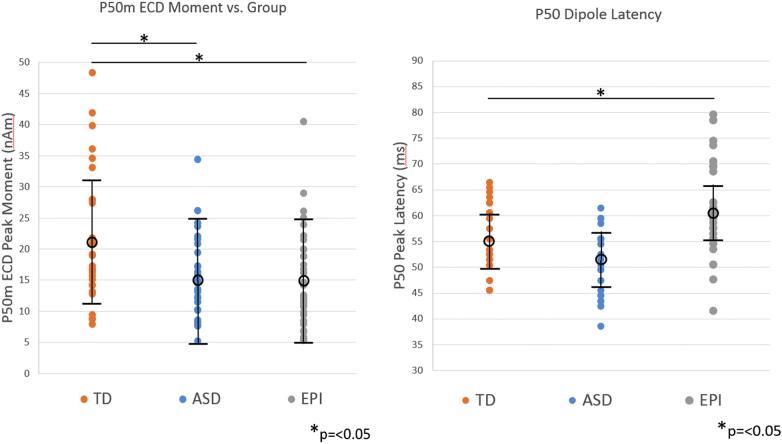
Left panel: Group mean and standard deviations for dipole moment reveal a significant overall effect of group F(2,41) = 4.21, p < 0.05. Independent post-hoc pair wise comparisons showed means were significantly different TD (21.3 ± 7.0nAm(SD)) vs epilepsy (14.7 ± 6.6nAm), p < 0.02 and TD vs ASD (15.4 ± 7.4nAm).Right panel: Group mean and standard deviations for dipole peak latency: Significant overall effect of group F(2,41) = 12.0, p < 0.05. Post-hoc pair wise comparisons showed this to be driven by a latency delay of ~ 6 ms in the epilepsy group: means were significantly different TD (55.8 ± 5.4 ms) vs epilepsy (61.6 ms ± 5.0 ms), p < 0.02, but not significant for TD vs ASD (52.4 ± 5.4 ms), p = 0.9.